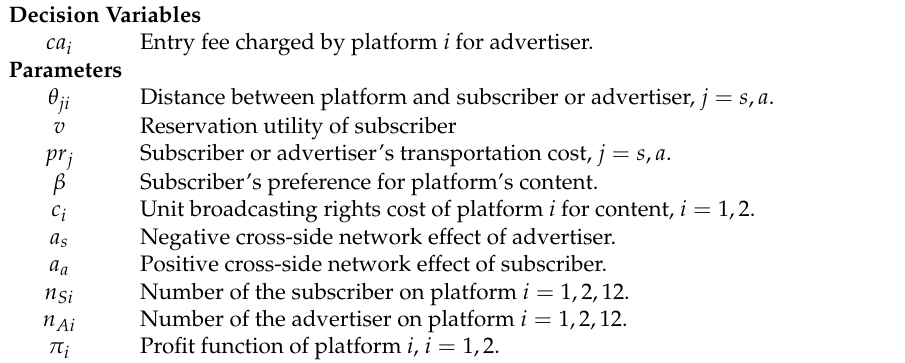
Table 2. Notations of parameters and